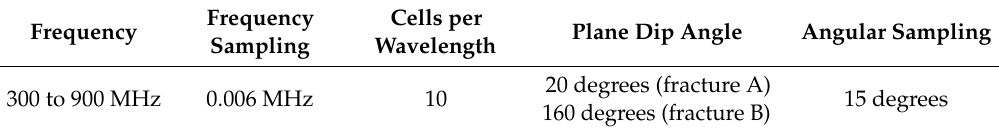
Table 2. Numerical simulation details.